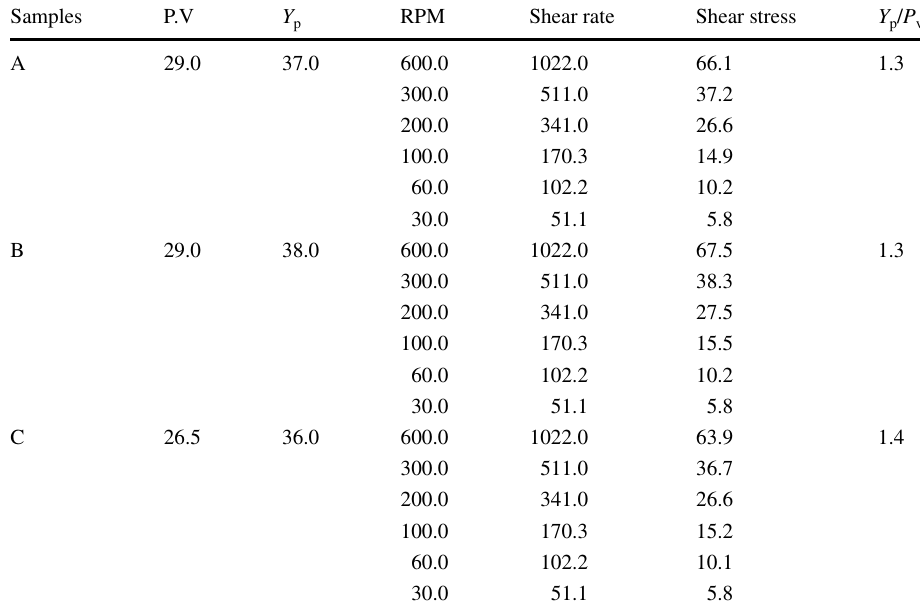
Table 15 Rheology property